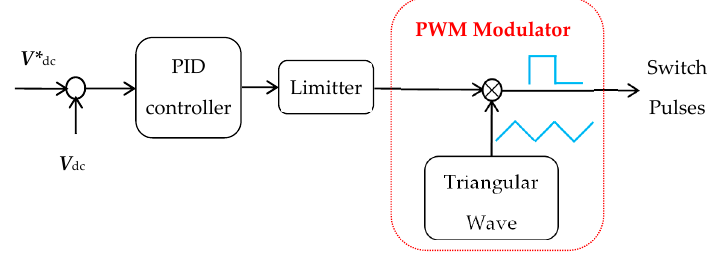
Figure 7. Boost converter controller block diagram.